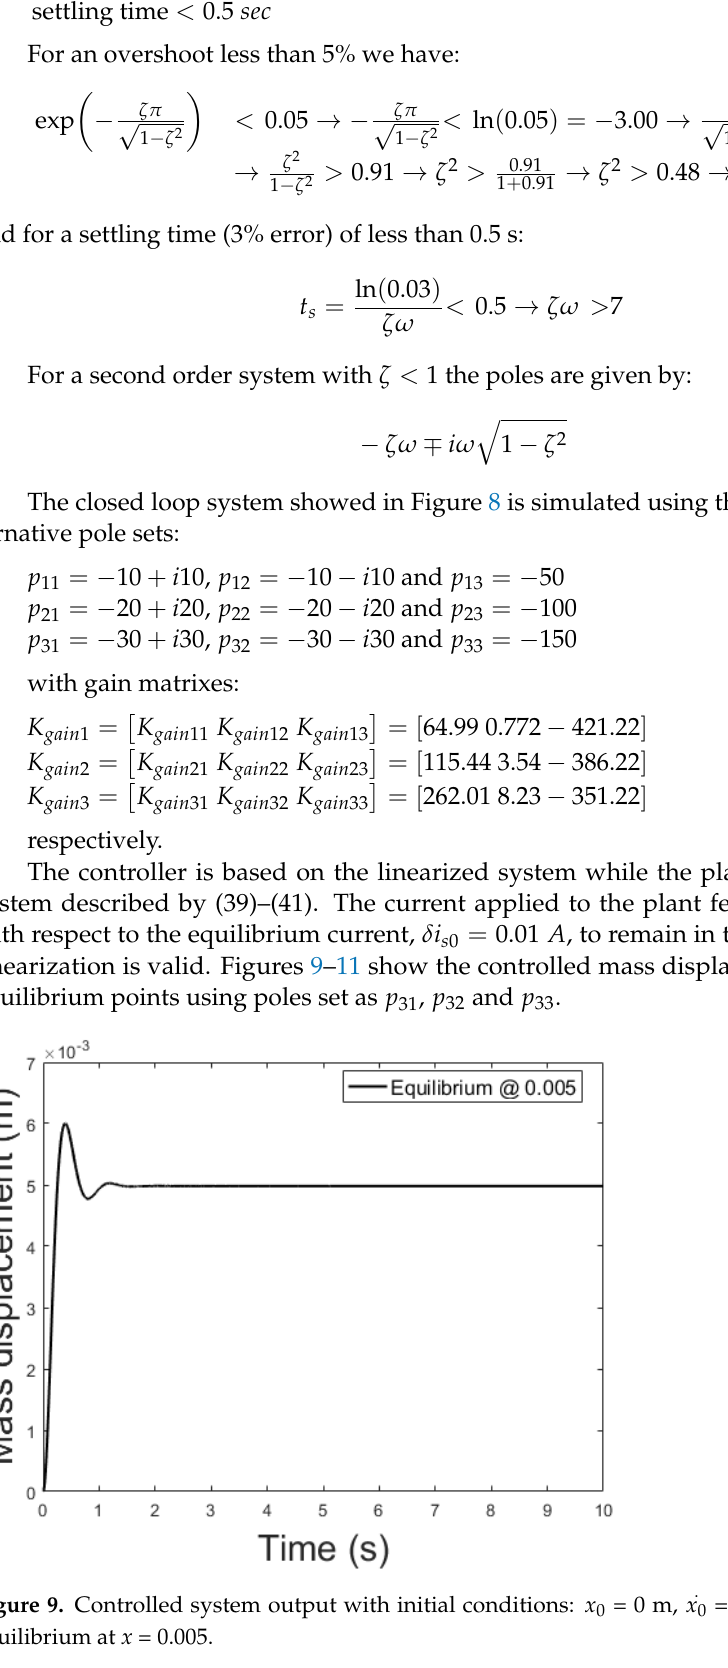
Figure 9. Controlled system output with initial conditions: x 0 = 0 m, equilibrium at x = 0.005.